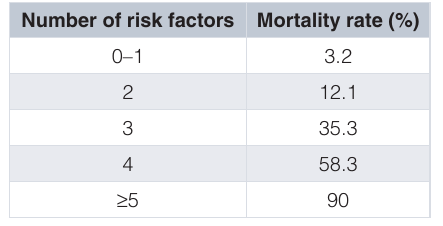
Table 3. Mortality rate in SCORTEN.